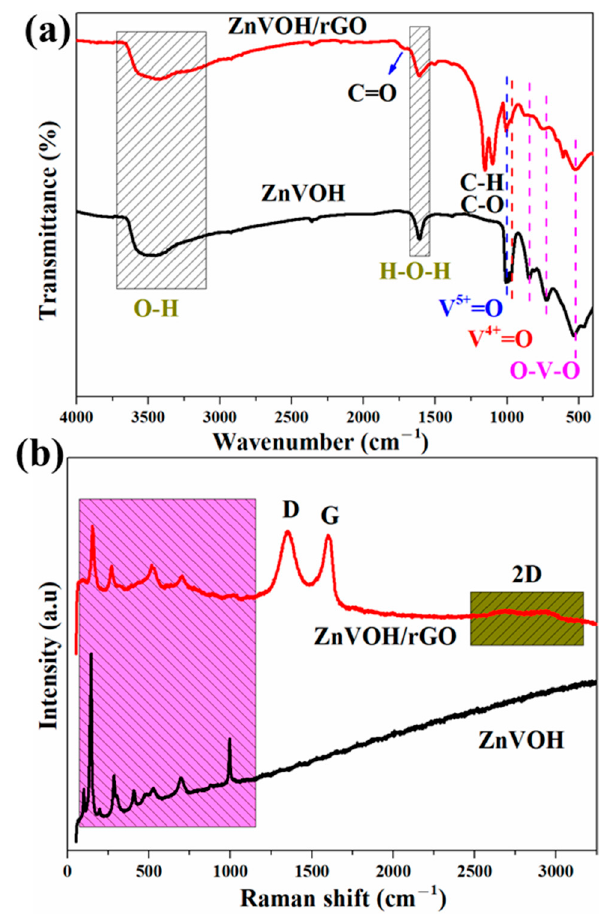
Figure 2. FTIR ( a ) and Raman ( b ) spectra of ZnVOH and ZnVOH/rGO. The Zn-ion storage performance of ZnVOH/rGO was tested (details in Supplementary Material). Figure 4a depicts CV curves of ZnVOH and ZnVOH/rGO at scan rate of 0.1 mV · s − 1 in 0.2~1.4 V potential range. They have two pairs of redox peaks, and they are assigned to the reactions of V 5+ /V 4+ and V 4+ /V 3+ , respectively. As for ZnVOH, these two pairs of redox peaks are located at 0.428/0.771 V and 0.760/1.201 V. However, they are shifted to 0.565/0.752 V and 0.843/1.045 V for ZnVOH/rGO. The potential gap of ZnVOH/rGO is much smaller than that of ZnVOH, revealing better redox reaction kinetics and faster ion diffusion leading to the smaller polarization. The above result suggests that the introduction of rGO is good for the redox reaction kinetics, and it also plays a role in promoting thermodynamics [47]. Figure 4b shows the CV curves of ZnVOH/rGO at the initial cycles. These curves are well overlapped, which indicates the excellently reversible Zn 2+ (de)intercalation of ZnVOH/rGO. Furthermore, two couples of redox peaks in all CV curves (Figure 4) are indexed to ingress/egress of Zn 2+ , suggesting a multistep intercalation mechanism